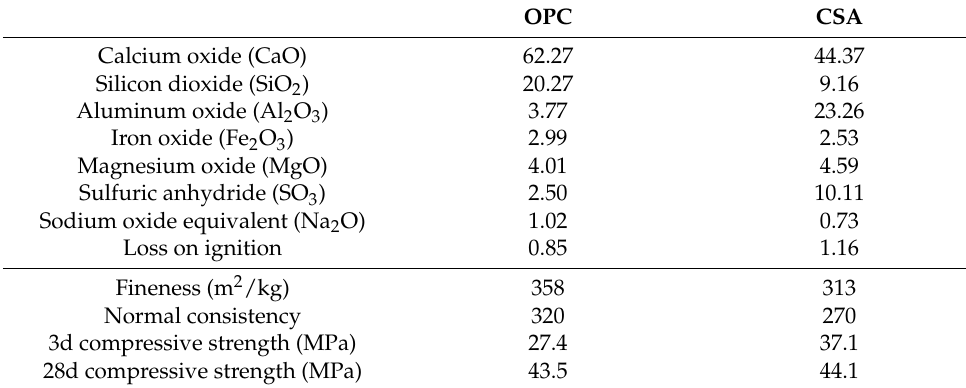
Table 1. The physicochemical properties of OPC and CSA cement.